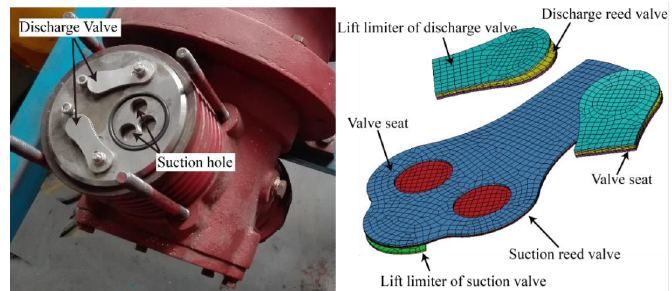
Figure 4. The structural domain model of the